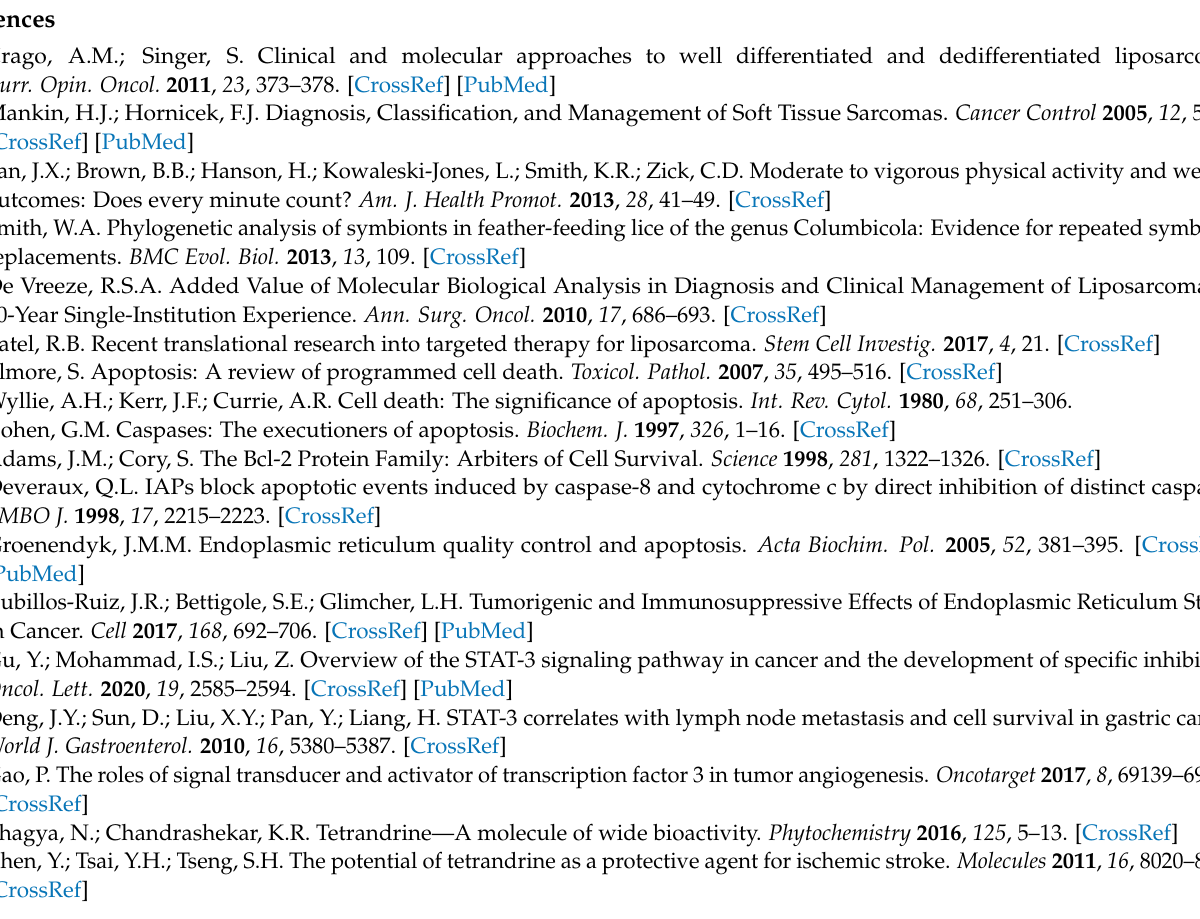
Table S2: The primer sequences used for RT-PCR